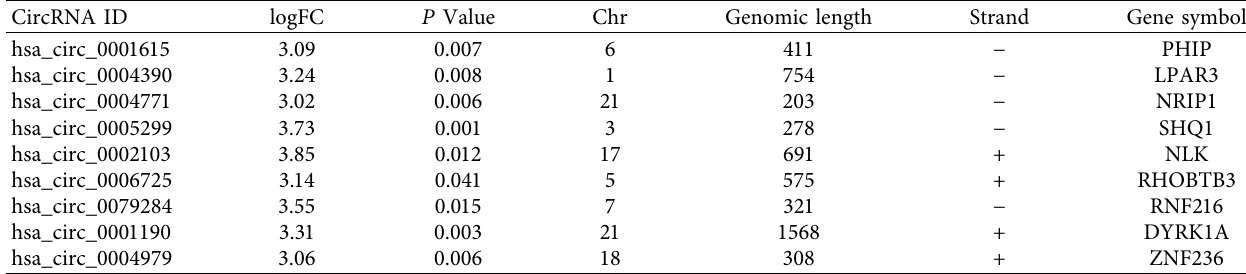
Table 2: The basic information of the 9 circRNAs in the ceRNA subnetwork. CircRNA ID logFC Genomic length